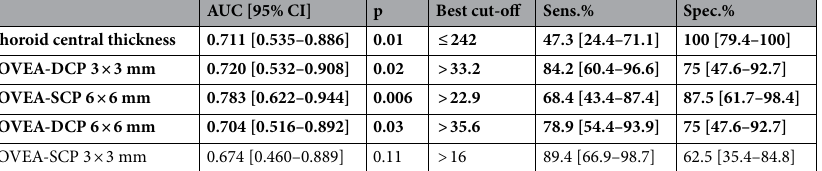
AUC [95% CI] p Best cut-off Sens.%